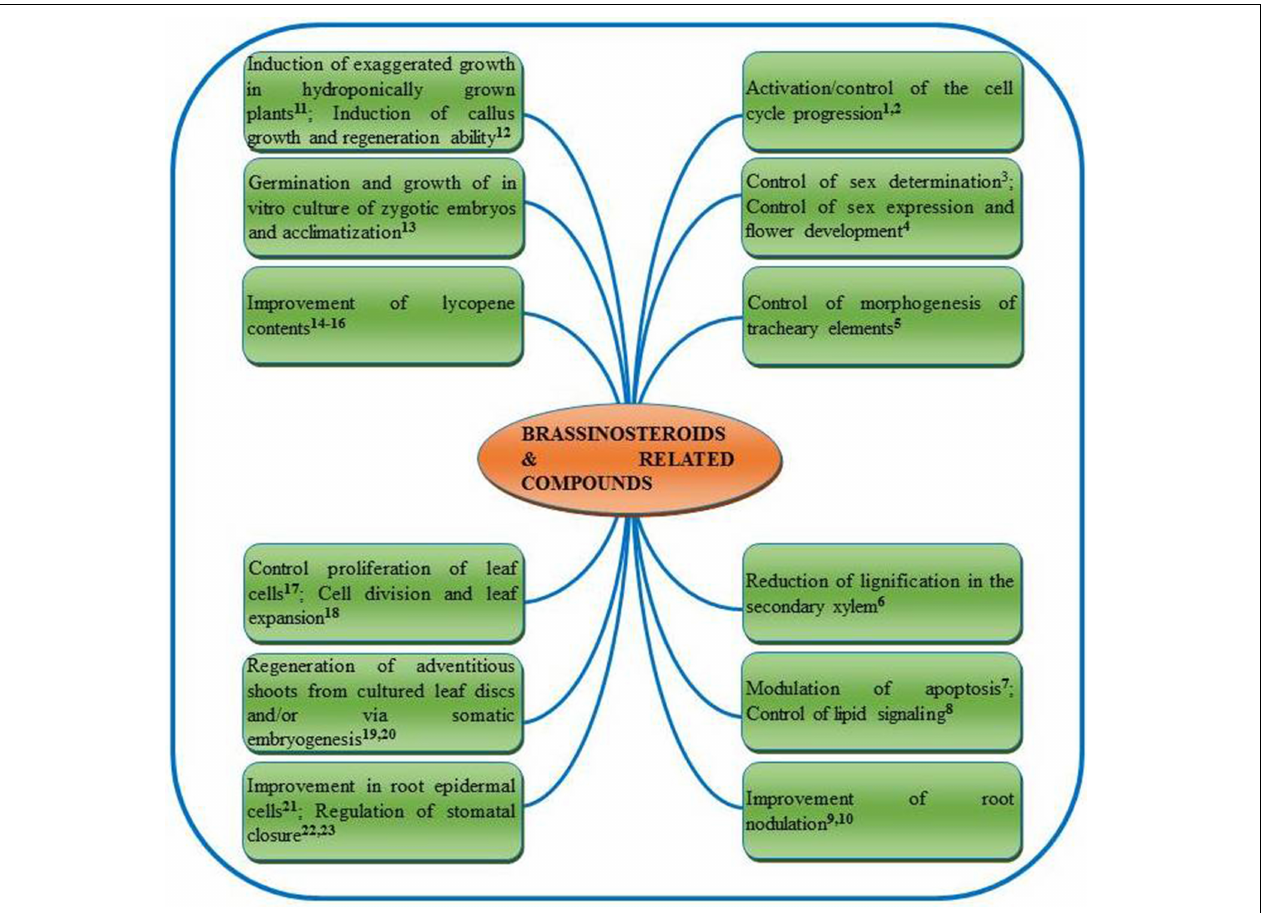
FIGURE 3 | Summarized roles of brassinosteroids and related compounds reported in plants. 1 Zadvornova et al., 2005; 2 González-Garcia et al., 2011; 3 Hartwig et al., 2011; 4 Manzano et al., 2011; 5 Yamamoto et al., 2001; 6 Jin et al., 2014; 7 Carange et al., 2011; 8 Pokotylo et al., 2014; 9 Vardhini and Rao, 1999; 10 Upreti and Murti,